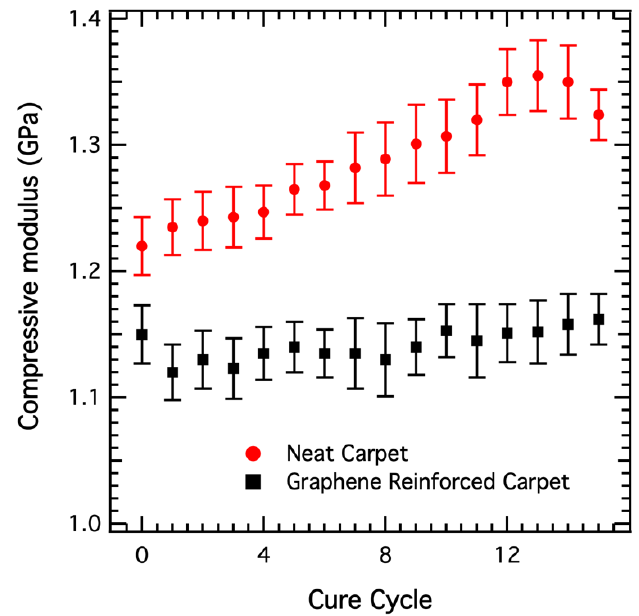
Figure 4. Compressive modulus value of neat and nanofiller reinforced carpet composite.